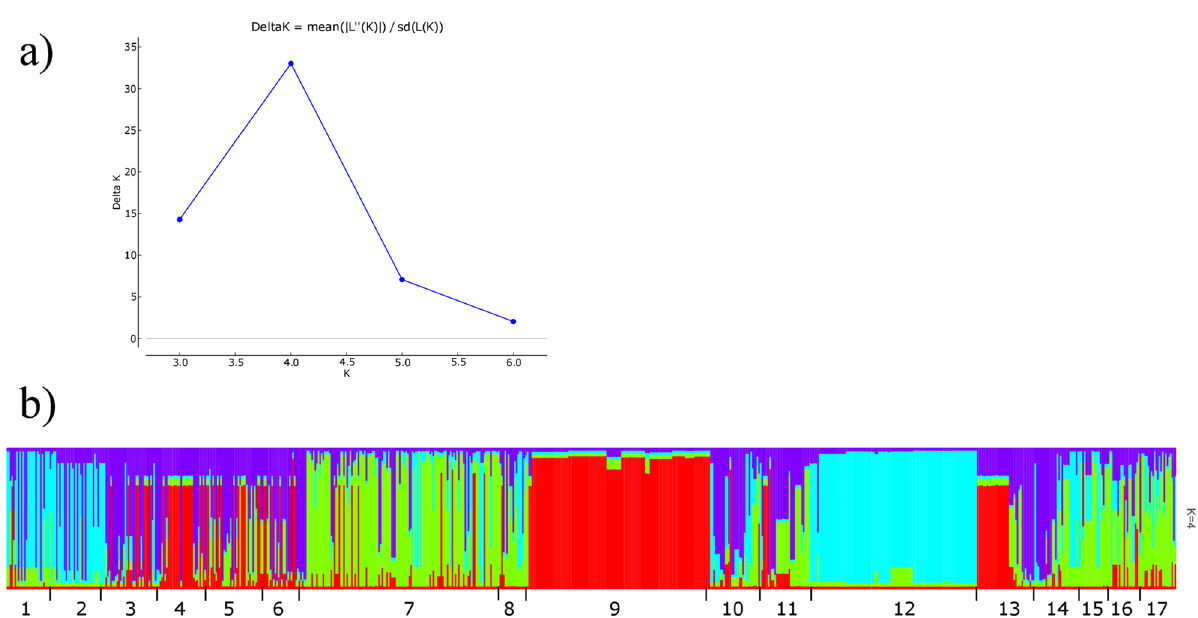
Figure 4. Relationships between pig populations. BIONJ dendrogram ( a ) and multidimensional scaling analysis ( b ) based on DA genetic distances calculated from SLA-DRB1 allele frequency. Bootstrap values are shown for each node in the dendrogram and clusters identified by both methods are depicted in the same colour.